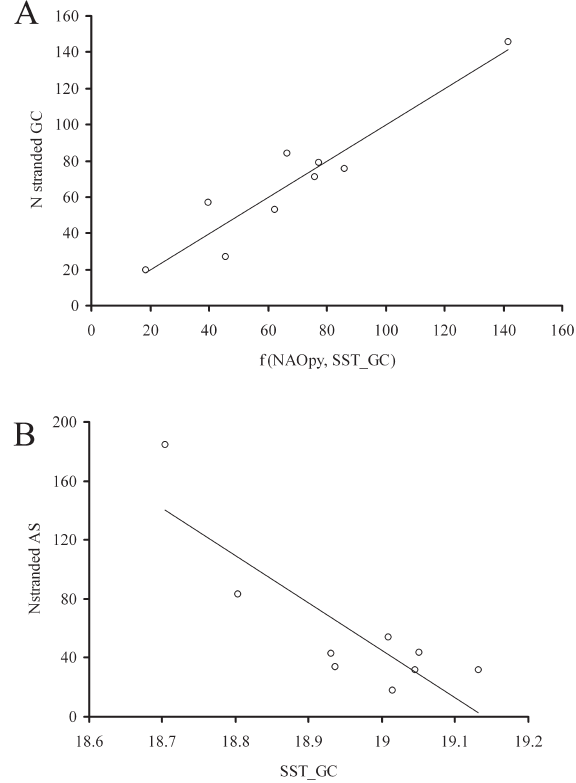
Fig 2 . – Linear response of loggerhead strandings as a function of the explanatory variables from 1997 to 2006: A) Linear response of the total number of loggerhead strandings in the Gulf of Cadiz as a function of the average SST in the Gulf of Cadiz between November and October, and the average NAO index between November and October of the year prior to that of the stranding; B) Linear response of the total number of loggerhead strandings in the Alboran Sea to the average SST in the Gulf of Cadiz between November and